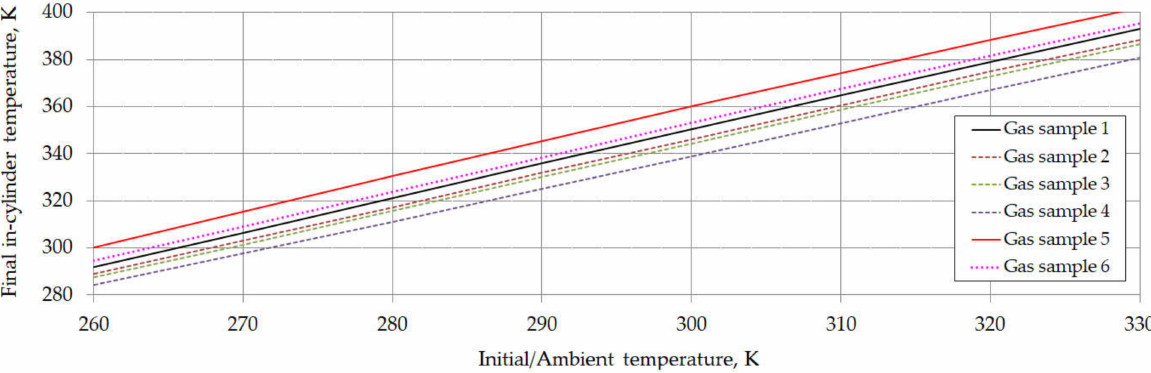
Figure 9. Influence of initial temperature (ambient) on the final in-cylinder temperature for the considered natural gas mixtures.